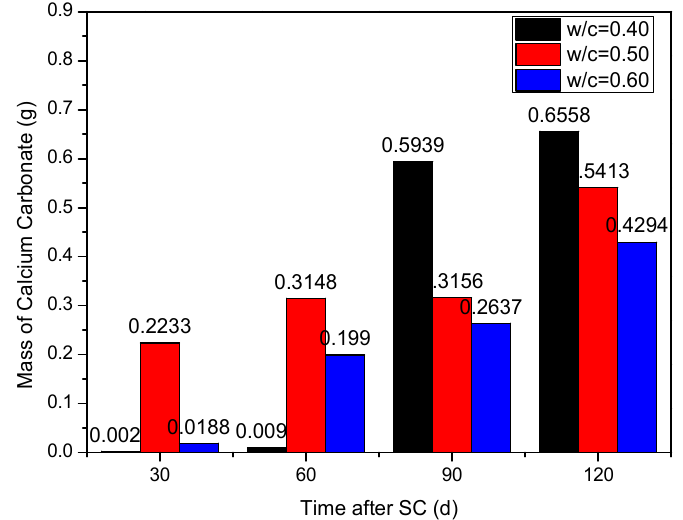
Figure 8. Statistics of the cathode side leachables of specimens with different water-binder ratios.